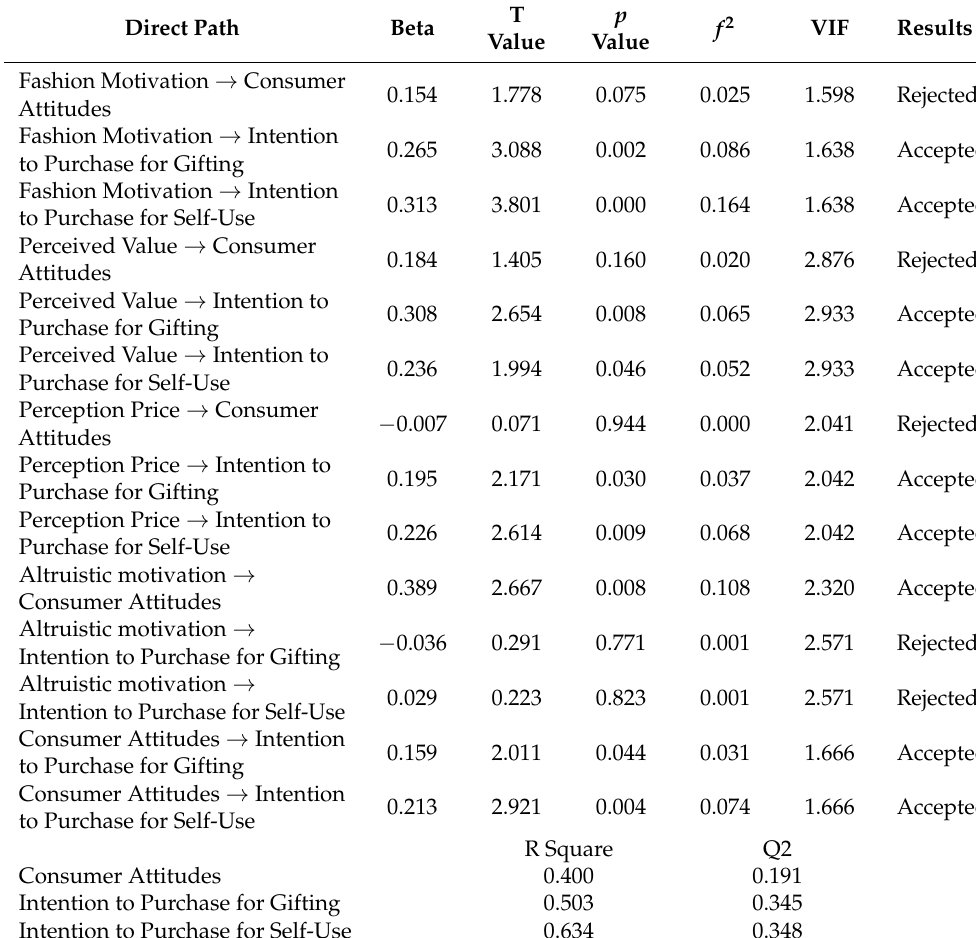
Table 3. Results of structural model evaluation and hypotheses